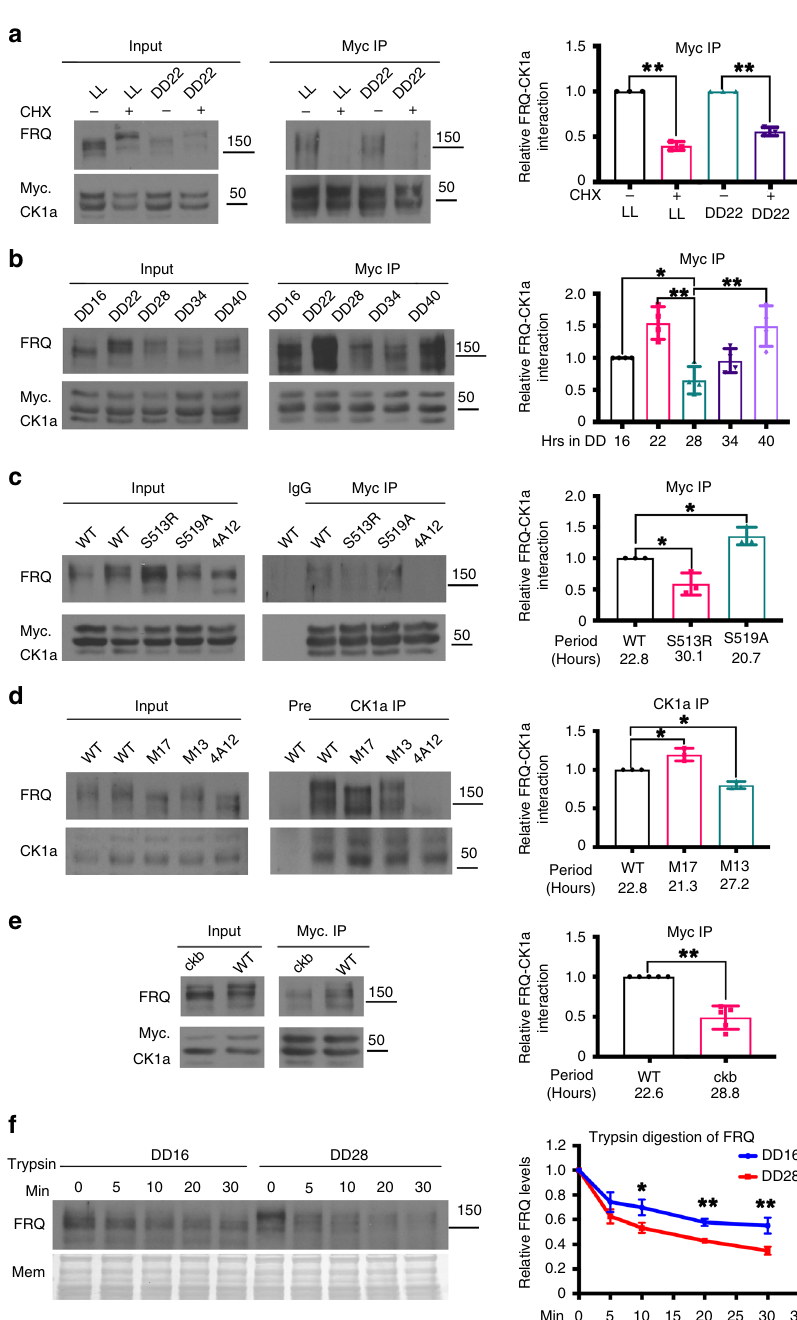
Fig. 3 Regulation of the FRQ-CK1a interaction by FRQ phosphorylation. a c-Myc immunoprecipitation assay in the wild-type strain with and without CHX treatment. The cultures were grown in LL or DD and were treated with CHX for 1 h before immunoprecipitation was performed. Quanti fi cation of relative FRQ-CK1a interaction levels is based on the ratio of IP to Input. The densitometric analysis is shown on the right. Error bars are standard deviations ( n = 3). ** P < 0.01. Student ’ s t -test was used. The position of the molecular weight marker is indicated. b c-Myc immunoprecipitation assay in the wild-type strain at indicated time points in DD. The densitometric analysis is shown on the right. Error bars are standard deviations ( n = 4). * P < 0.05, ** P < 0.01. Student ’ s t -test was used. c , d c-Myc ( c ) or CK1a ( d ) immunoprecipitation assays showing the relative FRQ-CK1a interaction in the indicated FRQ phosphorylation sites mutants in LL. Long period mutants (S513R, M13) showed reduced FRQ-CK1a interaction while the interaction was increased in the short period mutants (S519A and M17). ( n = 3). * P < 0.05. Student ’ s t-test was used. e c-Myc immunoprecipitation assays showing the relative FRQ-CK1a interaction is decreased in the long period ckb RIP mutant in LL. ( n = 5). ** P < 0.01. Student ’ s t -test was used. f Western blot showing trypsin digestion of hypophosphorylated (DD16) and hyperphosphorylated (DD28) FRQ. Densitometric quanti fi cation of full-length FRQ relative to the amount at time 0 is shown on the right. Error bars are standard deviations ( n = 4). * P < 0.05, ** P < 0.01. Student ’ s t -test was used. Source data are provided as a Source Data fi